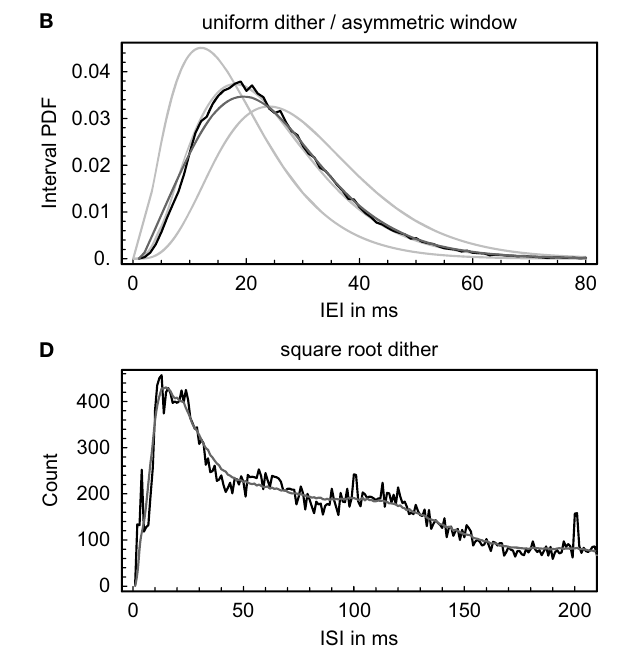
FIGURE 5 | Effect of dithering event times on the interval distribution. (A–C) Simulated event trains were generated by gamma processes of order 4, and event times were dithered individually and independently using three different methods (number of surrogates: 100).The resulting average probability density functions (PDF) of the inter-event intervals (IEI) are shown in comparison with the original data and with theoretical interval distributions of gamma processes of orders 3, 4, and 5. (A) Event times were dithered randomly and uniformly within a symmetric window of maximally ± 20ms, but assuring a “refractory period” of 1ms between events.The average absolute displacement of an event resulted in 4.1ms.